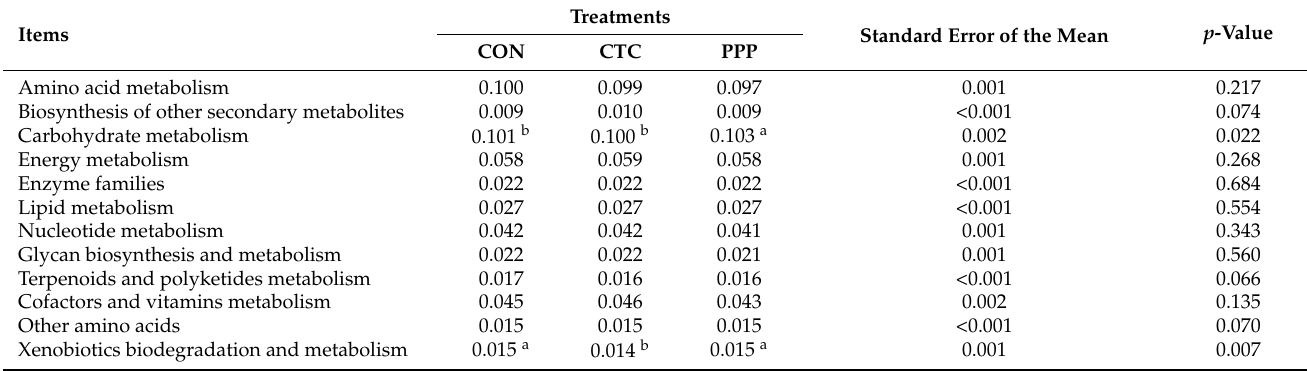
Table 9. Dietary pomelo peel powder affected the metabolism function of colonic